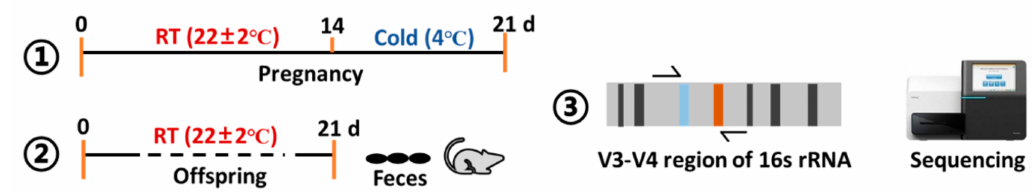
Figure 1. Treatment protocol and schematic workflow to examine the gut microbiota composition.